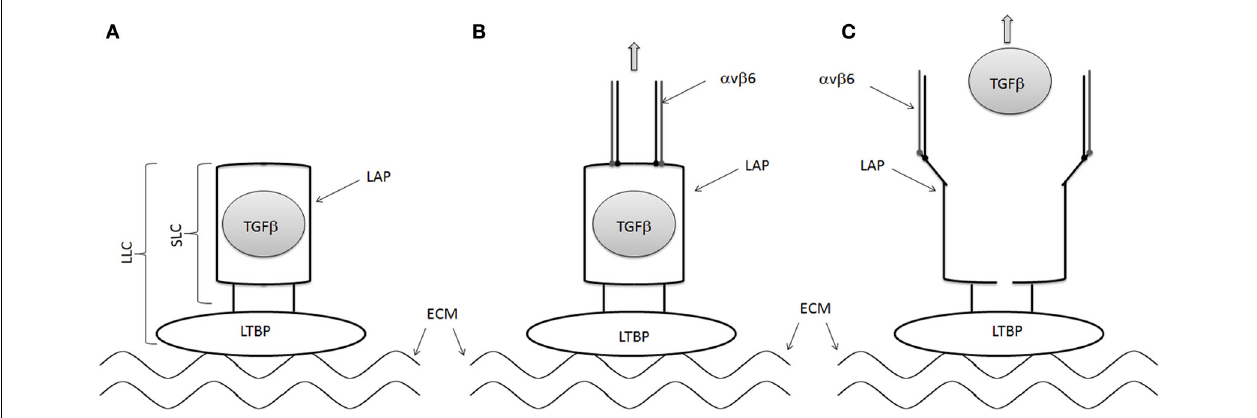
FIGURE 1 | Mechanisms of TGF β activation by α v β 6 integrin. (A) LAP forms a straightjacket around TGF β in the small latent complex (SLC) and binds to LTBP to for the large latent complex (LLC). The LTBP is in turn tethered to the extracellular matrix. (B) The cell associated α v β 6